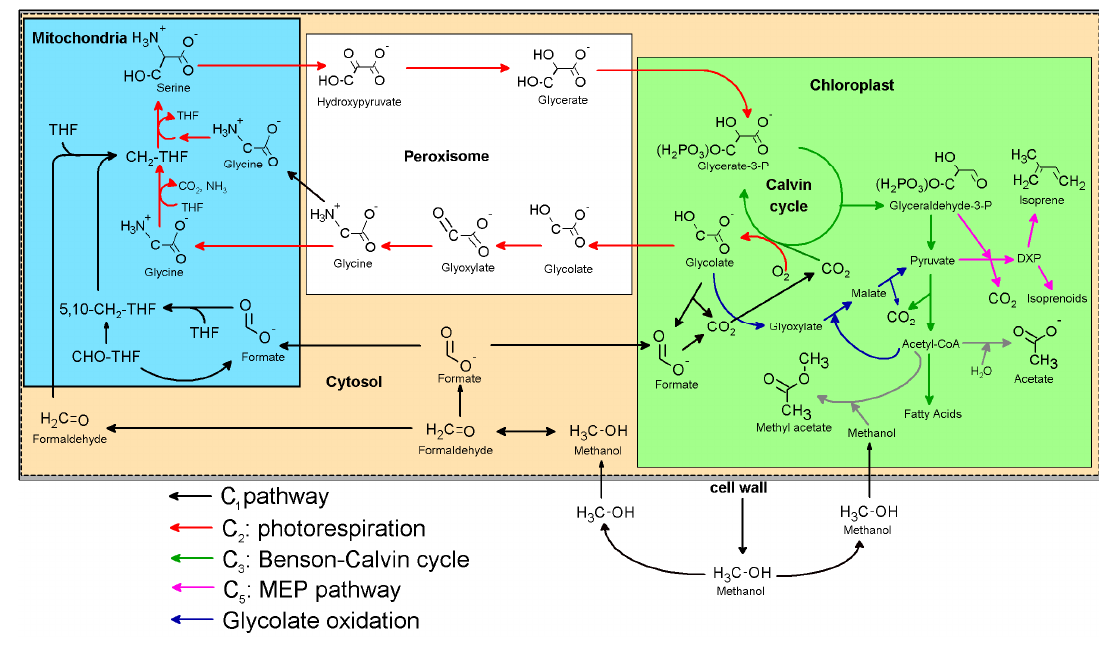
Figure 7. Simplified schematic model of the integration of the C 1 pathway into C 2 , C 3 , and C 5 metabolism in a photosynthetic plant cell. Note that the C 1 pathway supports both photorespiration in mitochondria by producing 5,10-CH 2 -THF and photosynthesis in the chloroplast by producing CO 2 .